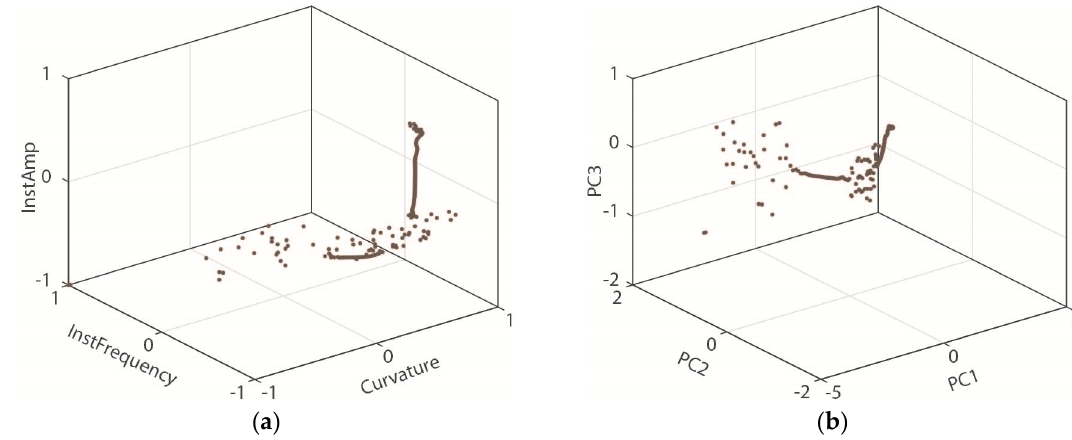
Figure 4. The cross plots of the seismic attributes ( a ) and the principal components (PCs) ( b